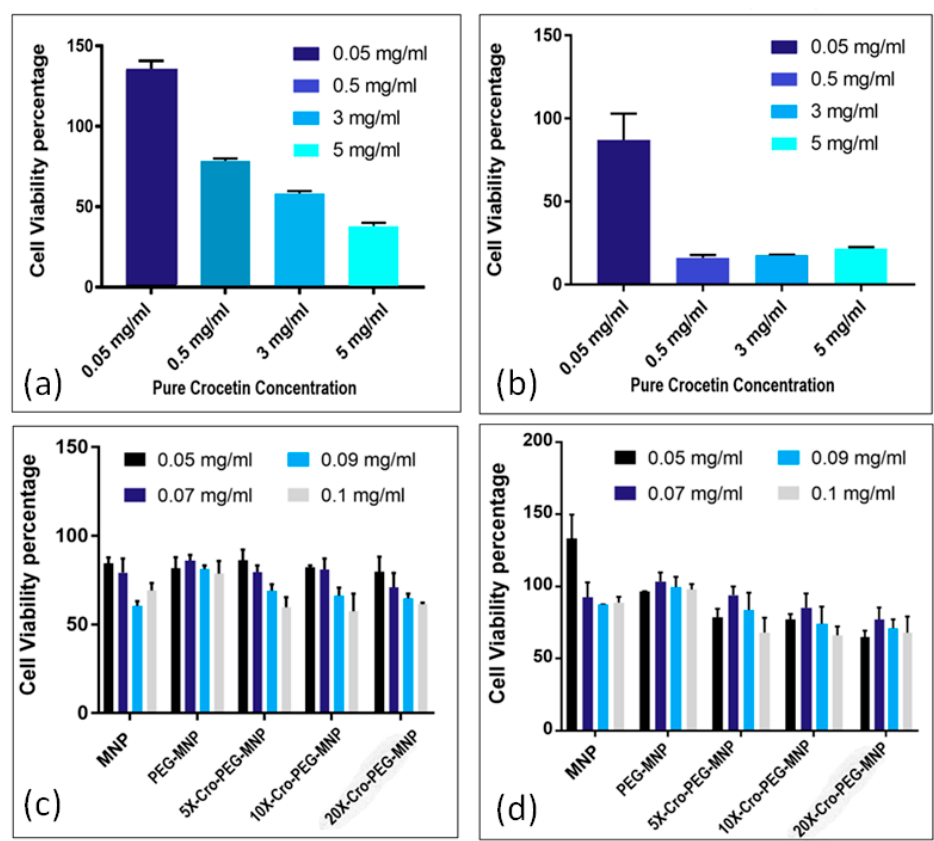
Figure 8. ( a ) Cell viability of HepG2 cells against pure crocetin as a function of the concentration of crocetin after 24 h of culture at 37 ◦ C. ( b ) Cell viability of HepG2 cells against pure crocetin after 72 h of culture at 37 ◦ C. ( c ) Cell viability of HepG2 cells against crocetin-functionalized PEG-coated MNPs after 24 h of culture at 37 ◦ C. ( d ) Cell viability of HepG2 cells against crocetin-functionalized PEG-coated MNPs after 72 h of culture at 37 ◦